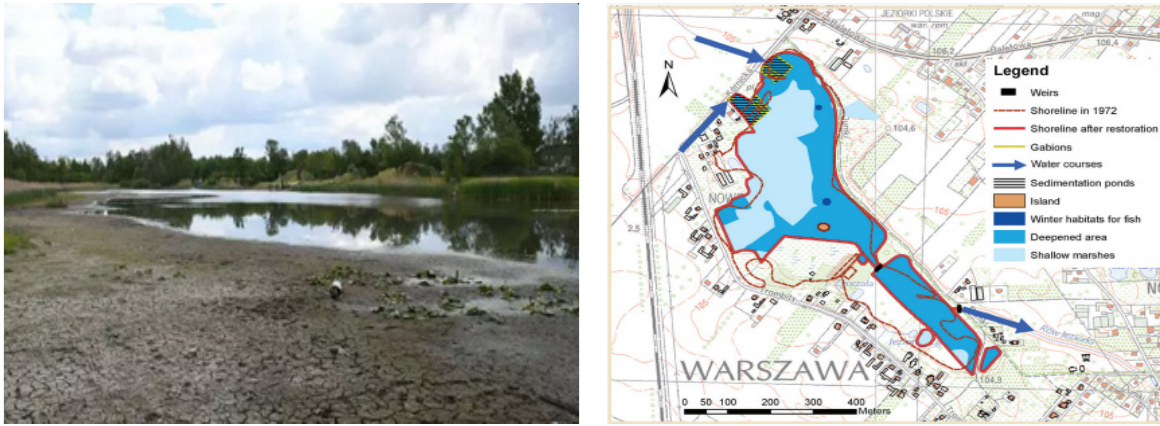
Figure A10. Dried-up Zgorza ł a Lake and site plan of the restoration project at Zgorza ł a Lake (source: own).